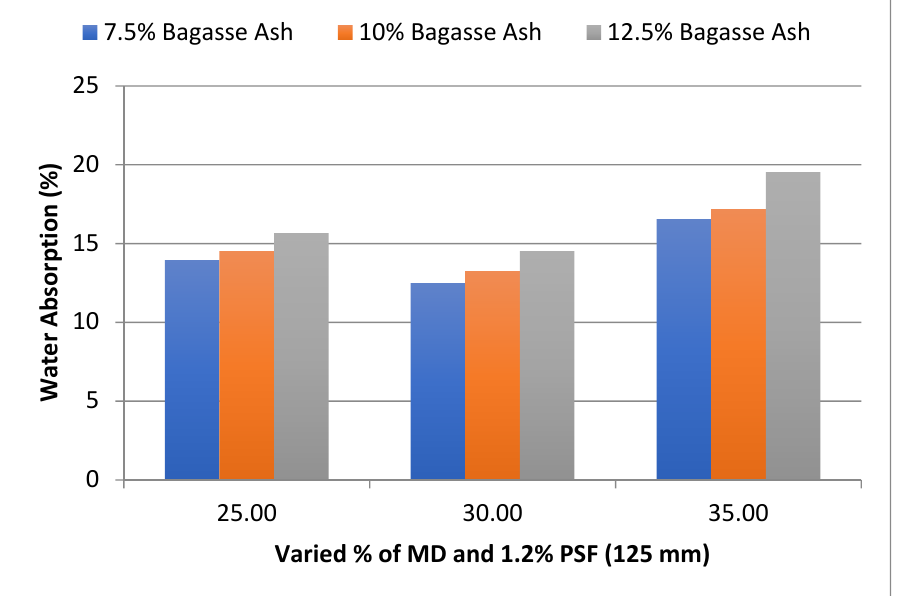
Figure 10. Effect of MD and BA on water absorption of block reinforced with 1.2% PS fiber (125 mm).